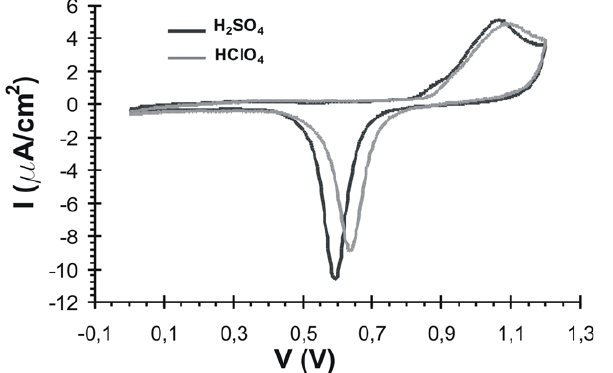
Figure 4. Analysis of the influence of the CE geometry. Change of the measured current in the two types of sensors due to the LPS (100 µ gmL − 1 ) interaction with the PmB (100 µ gmL − 1 ) immobilized via SAM.